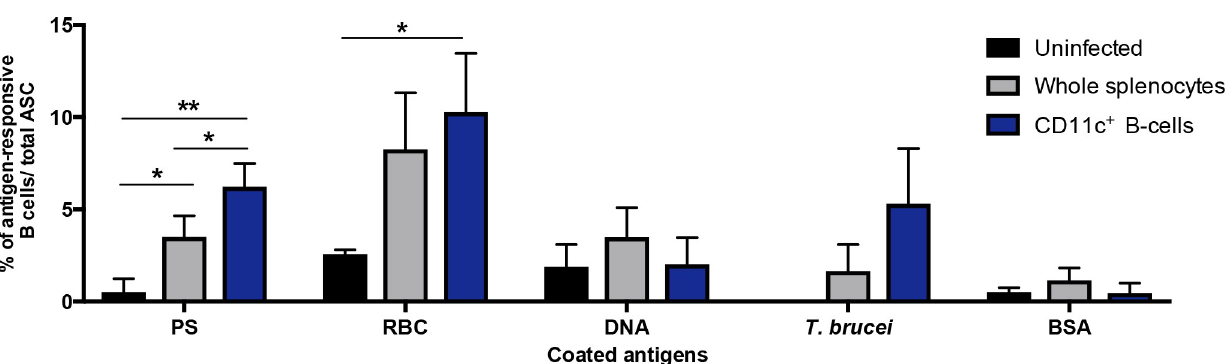
Fig 4. ABCs secrete autoantibodies during acute T . b . brucei infection in mice. B-cell ELISPOT of whole splenocytes or enriched CD11c+ B cells from uninfected and T . b . brucei -infected mice at day 10 post infection against coated antigens: Phosphatidylserine (PS), uninfected red blood cell lysate (RBC), Calf thymus DNA, Trypanosoma brucei parasite lysate and bovine serum albumin (BSA). Each data point represents the mean ± SD of n = 3 mice. Experiments were repeated 2 times, one representative example is shown. Significance determined by one-way ANOVA. � p < 0.05, �� p < 0.01.